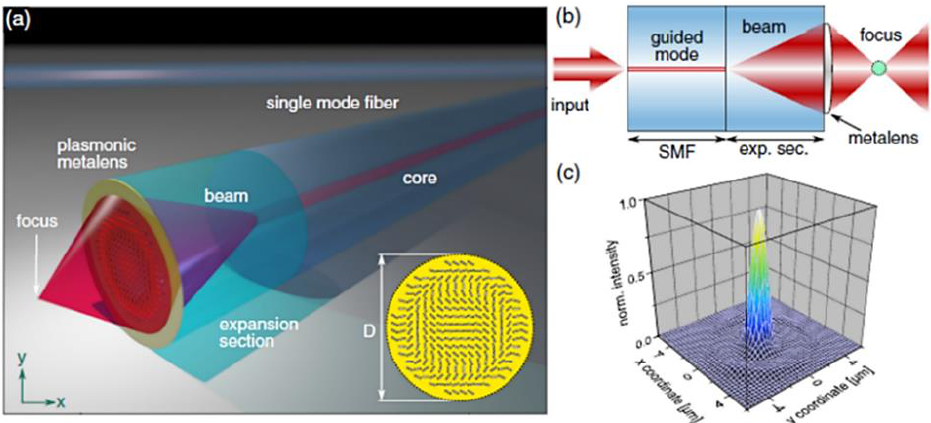
Figure 4. ( a ) Schematic of gold-coated plasmonic metasurface interfacing with single-mode step- index fiber. ( b ) Illustration of the interfacing structure including fiber expansion section. ( c ) Measured transverse intensity distribution of the focused spot in the focal plane. Reprinted with permission from Ref. [49]. Copyright 2021, WILEY-VCH.